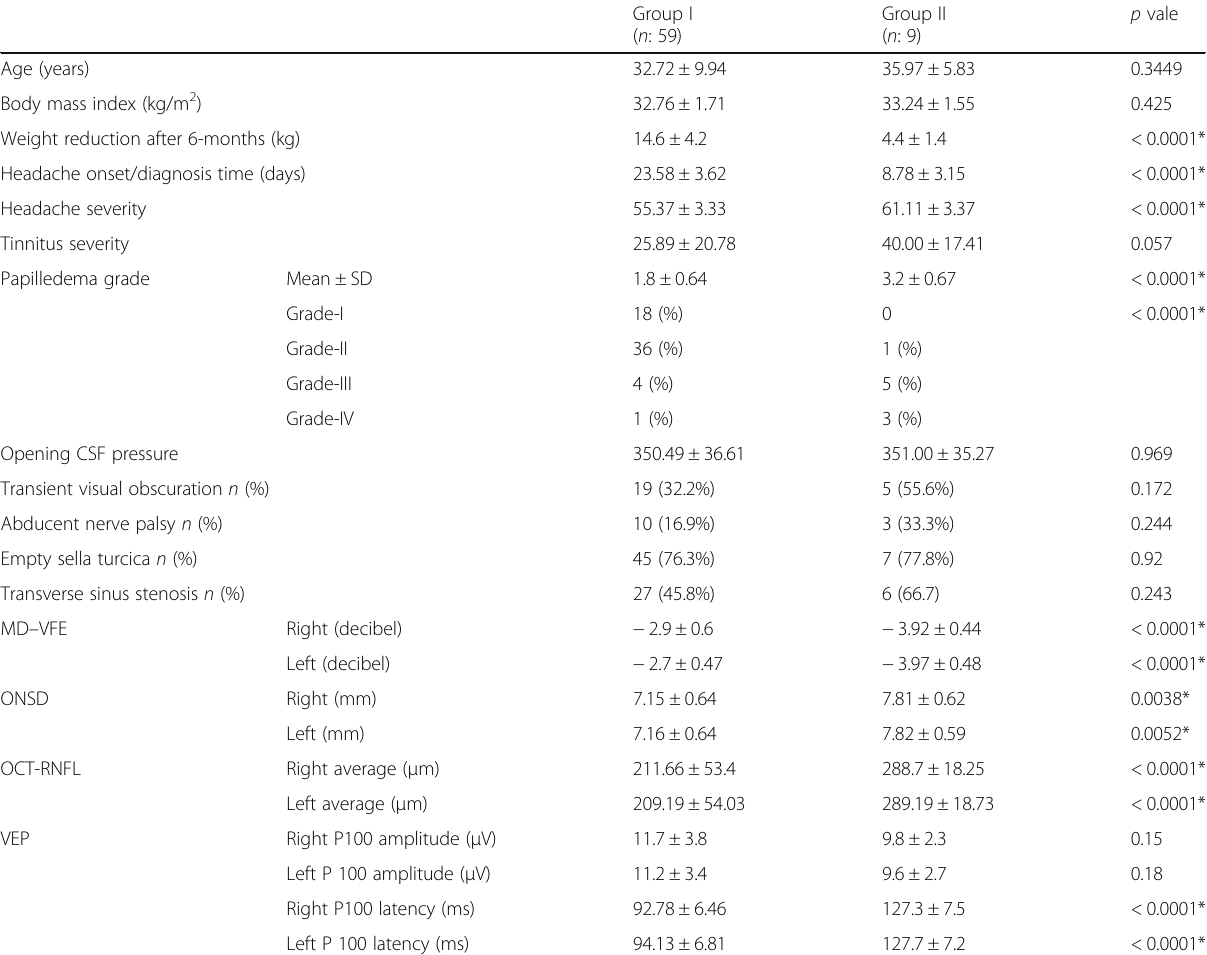
Table 1 Comparison between medically responded IIH patients (group I) and those who needed lumbo-peritoneal shunts (group II) at initial baseline assessment visit